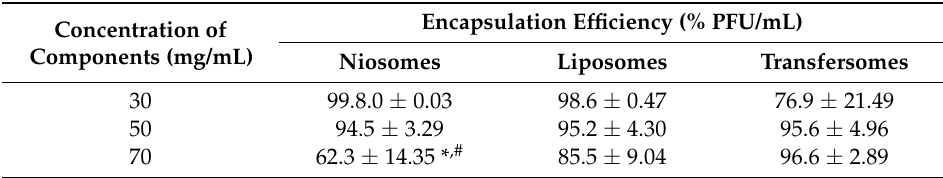
Table 2. Encapsulation efficiency for bacteriophage phiIPLA-RODI in niosomes, liposomes and transfersomes prepared using different concentrations of